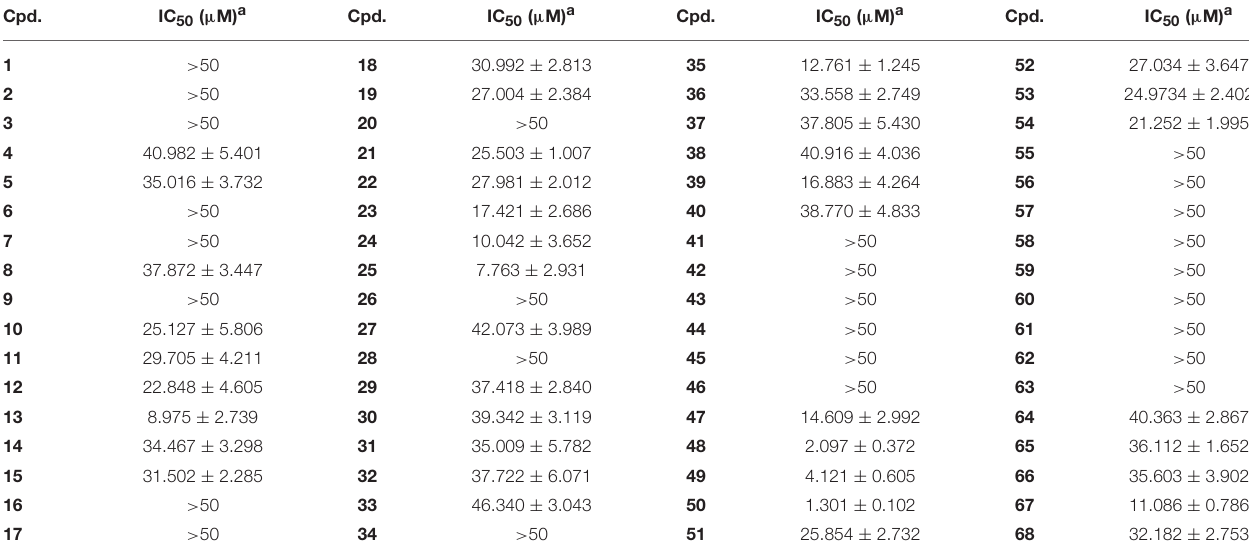
TABLE 1 | Kinase activity assay of coumarins. Cpd.